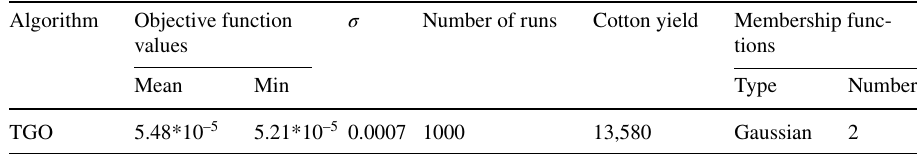
Table 8 Mean and minimum values of the objective function for 1000 times of